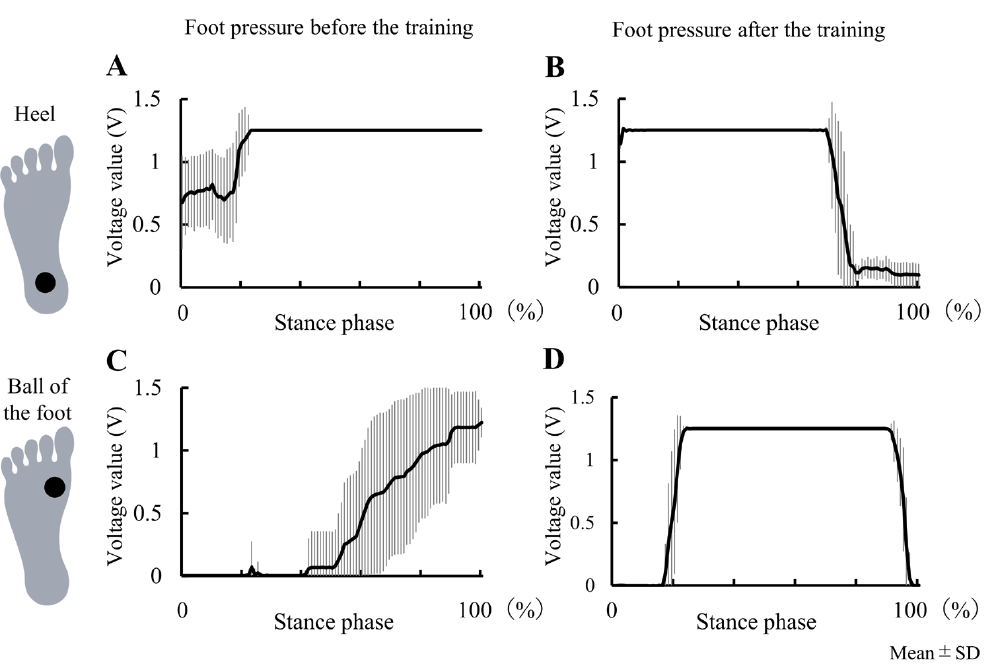
Figure 4. Foot pressures of the heel and the ball of the foot on the affected side during gait (stance phase) before and after nine days of robot-assisted gait training. Graphs indicate the voltage values of the foot pressures of the heel and the ball of the foot on the affected side. The horizontal axis indicates one stance phase, with 0% indicating initial foot contact on the affected side and 100% indicating toe off on the affected side. The thick solid line represents the mean voltage value, and the thin vertical line represents the standard deviation. Heel pressure responded throughout the stance phase before training ( A ), however, after training the response decreased in about 80% of the stance phase ( B ). Ball of the foot pressure was slow to rise in response before training ( C ), and the reaction started in the latter half of the stance phase, after training, the reaction started in about 20% of the stance phase ( D ). Data from the two sensors suggested an increase in forward load transfer in the stance phase.